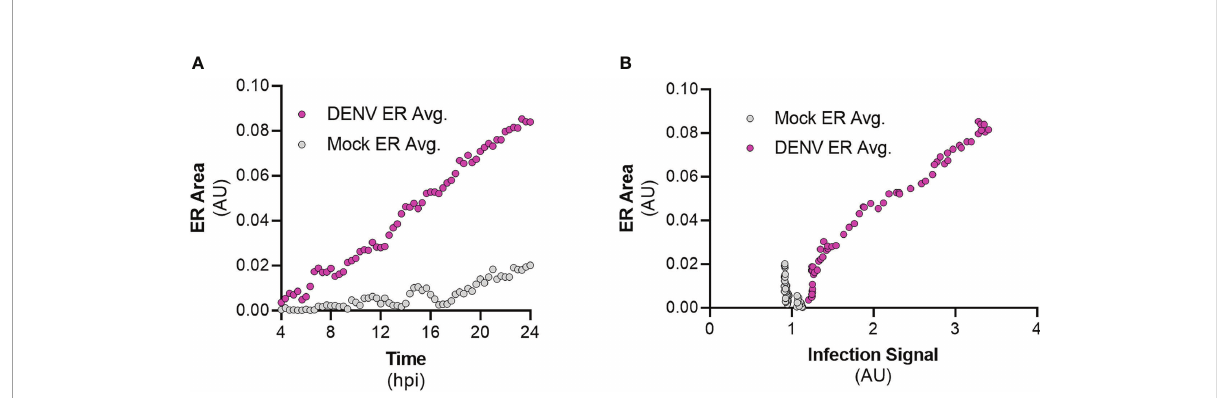
FIGURE 8 DENV infection correlates with ER expansion in a time-dependent manner. (A) Quanti fi cation of ER intensity for mock (gray, n=12) and DENV- infected cells (magenta, n=14) over the course of a 24-hour infection. (B) Correlation analysis between ER intensity and infection for mock (gray, n=12) and DENV-infected cells (magenta, n=14).